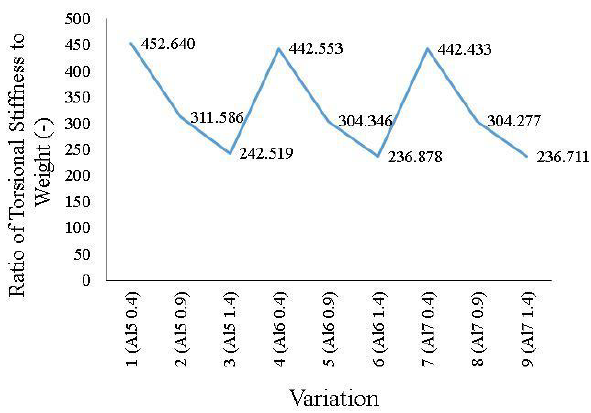
Figure 23: Ratio of torsional stiffness to the weight